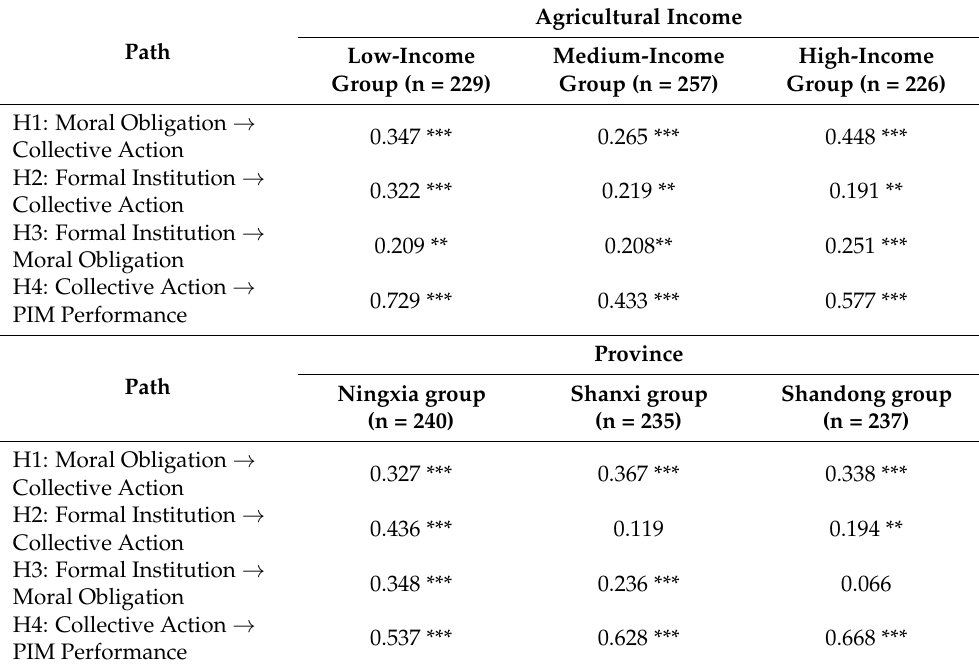
Table 5. Results of multi-group